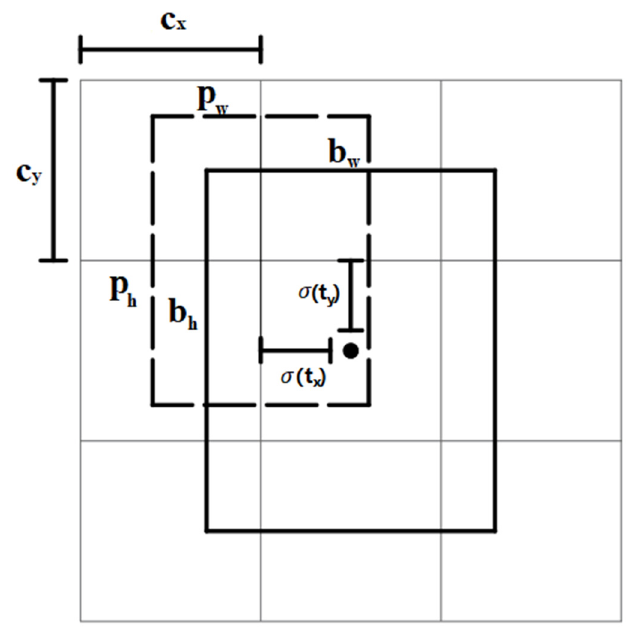
Figure 7. Bounding boxes with dimension priors and location prediction.